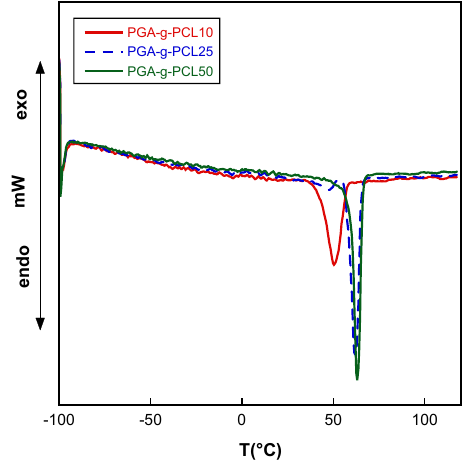
Figure 3. DSC thermograms of PGA ‐ g ‐ PCL copolymers.